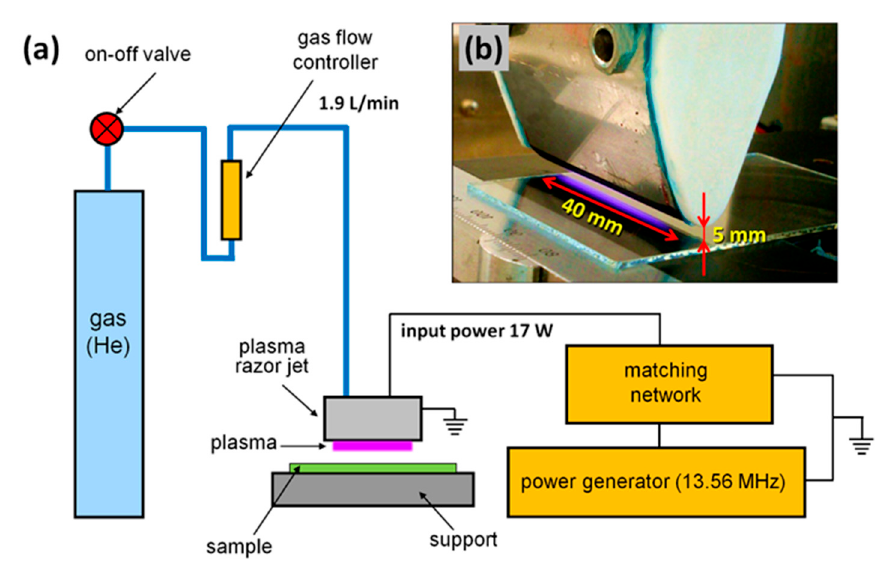
Figure 5. The experimental system: ( a ) schematic diagram of the setup; ( b ) photo of the plasma razor jet.